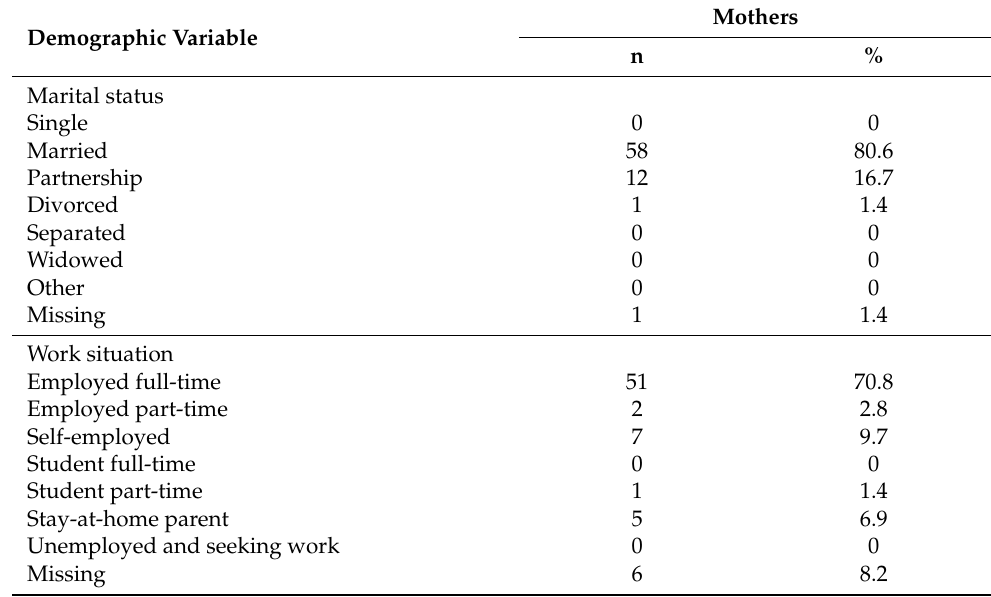
Table 1. Socio-demographic characteristics of the study